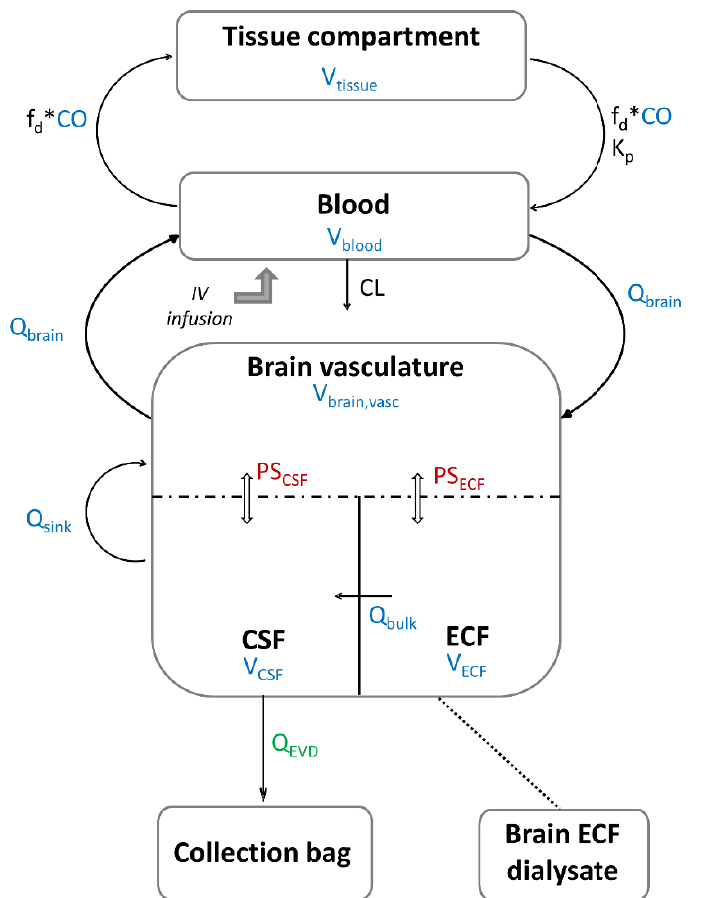
Figure 5. Schematic representation of metronidazole minimal PBPK model: the values of the param- eters in color are fixed and those of the parameters in black are estimated. Parameters in blue are system-specific parameters, the parameter in green is determined experimentally, and parameters in red are parameters derived from system- and drug-specific parameters. The dashed line represents the blood–brain barrier (BBB) and the blood–cerebrospinal fluid barrier (BCSFB). ECF: extracellular fluid, CSF: cerebrospinal fluid, CO: cardiac output, Q brain : cerebral blood flow, Q bulk : bulk flow, Q sink : sink flow, Q EVD : flow of the external ventricular drain, PS ECF : rate of bidirectional passive unbound drug transfer across the BBB, PS CSF : rate of bidirectional passive unbound drug transfer across the BCSFB, V blood : blood volume, V tissue : volume of non-CNS tissue compartment, V brain,vasc : brain vascular volume, V ECF : ECF brain tissue volume, V CSF : cranial CSF volume, fd: fraction of CO going to the non-CNS tissue compartment, K p : unbound tissue to blood partition coefficient, CL: total blood clearance.